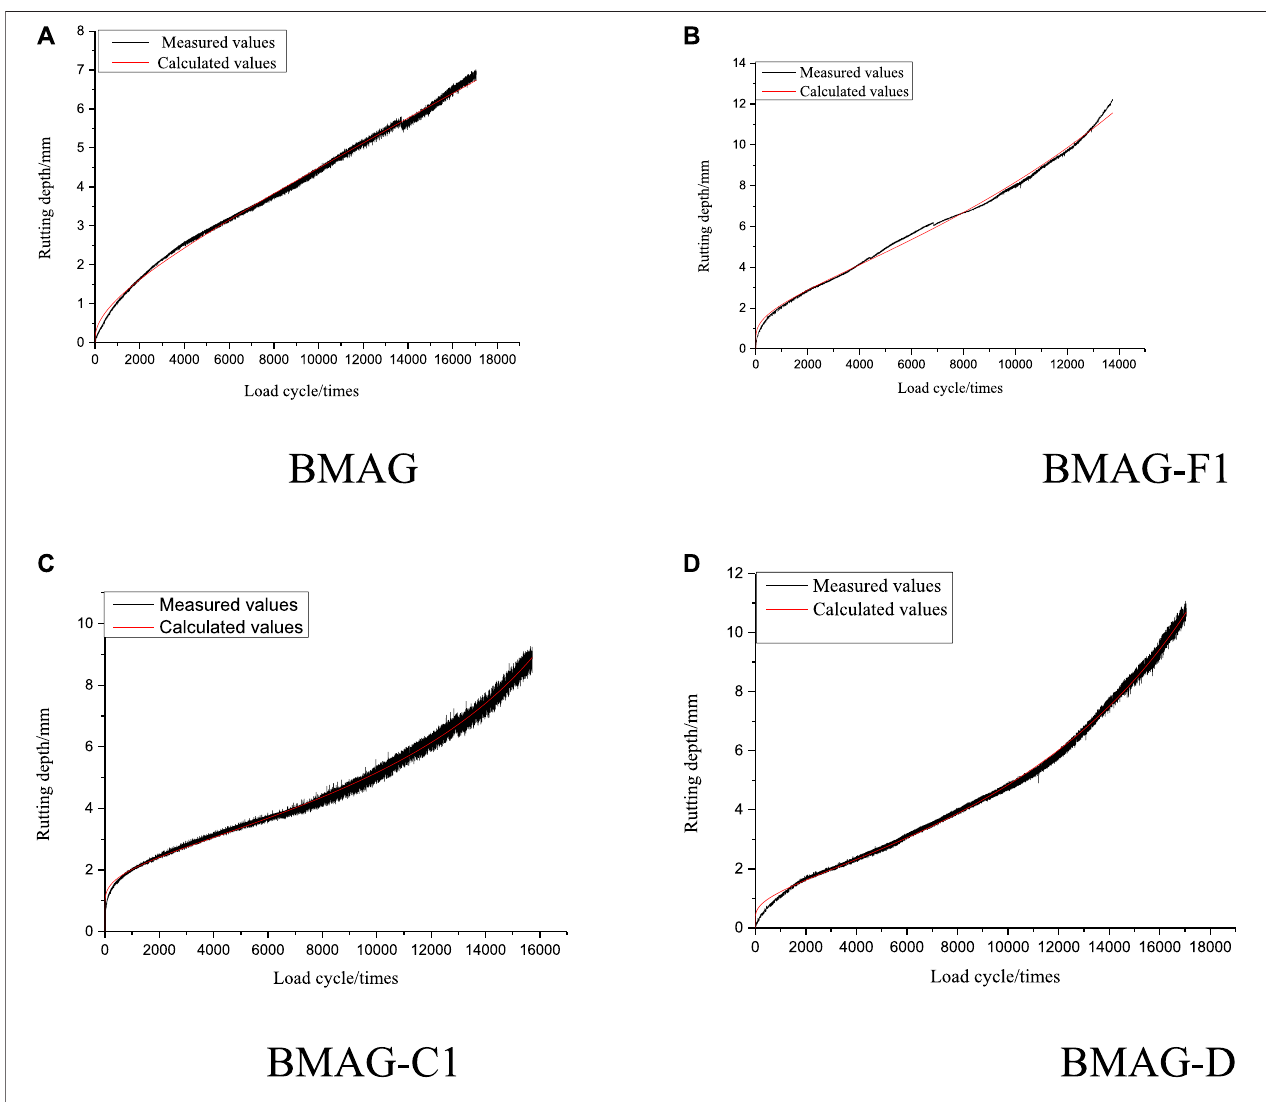
FIGURE 7 | Relationship between rut depth and load cycle times of HMA of different gradation: (A) BMAG, (B) BMAG-F1, (C) BMAG-C1, and (D) BMAG-D.